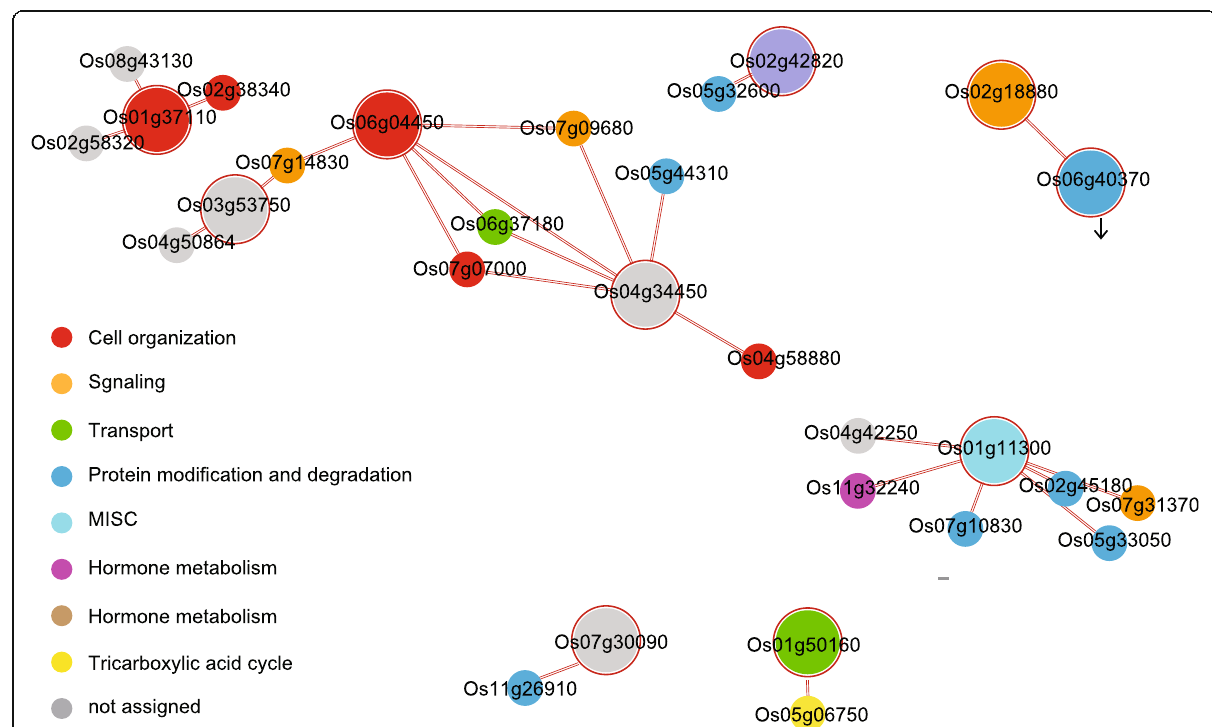
Fig. 4 Proposed functional network of root hair-preferential genes. Networks were refined by showing nodes with PCC values > 0.5. Functional classifications using MapMan terms are incorporated in simplified networks, as indicated by colors within